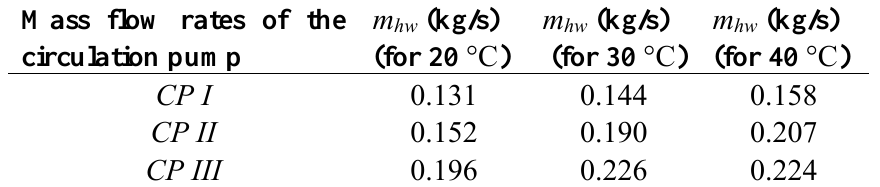
Table 2. Mass flow rates of the utilization hot water according to the circulation pump